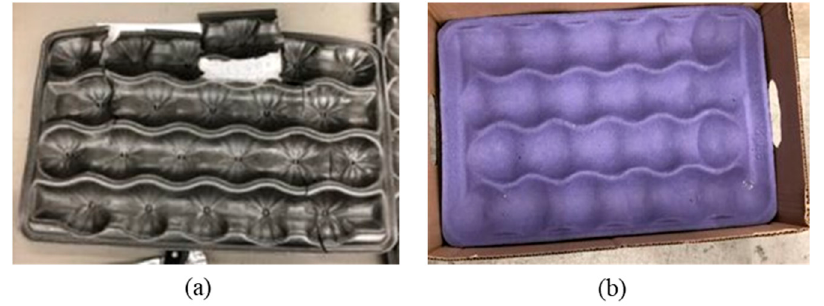
Figure 11. Example of tray damage, ( a ) EPS and ( b ) MF.